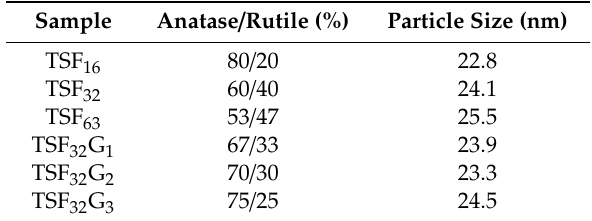
Table 1. Anatase / rutile percentage and particle size (nm) in the TSF and TSF 32 G coated films. Sample Anatase / Rutile